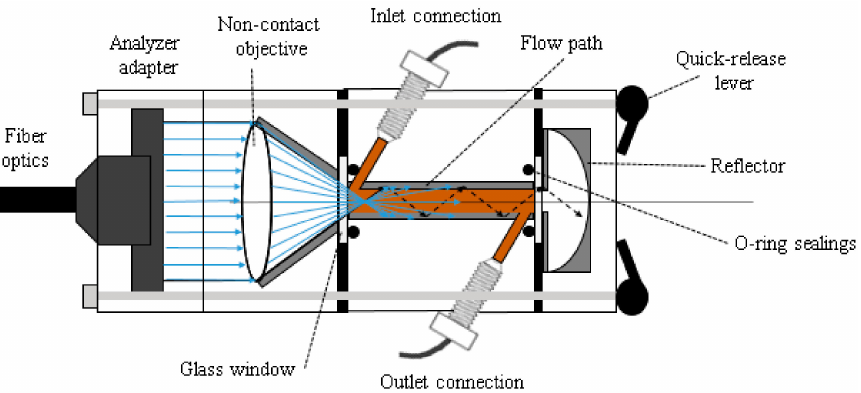
Figure 1. Schematic illustration of the developed flow